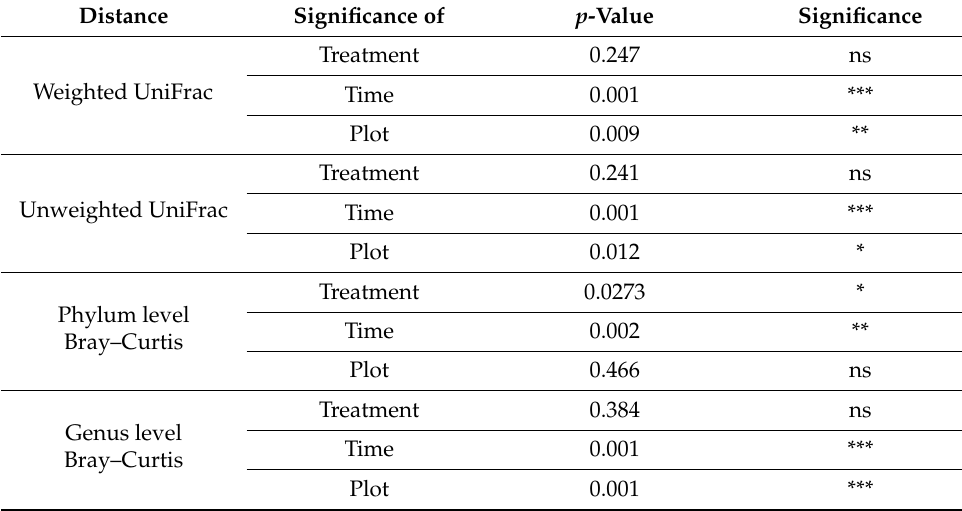
Table 1. Multivariate analysis of beta